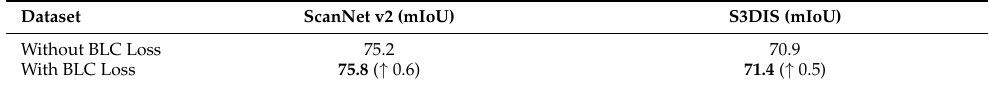
Table 13. Ablation studies on the proposed BLC loss. The bold denotes the best performance.